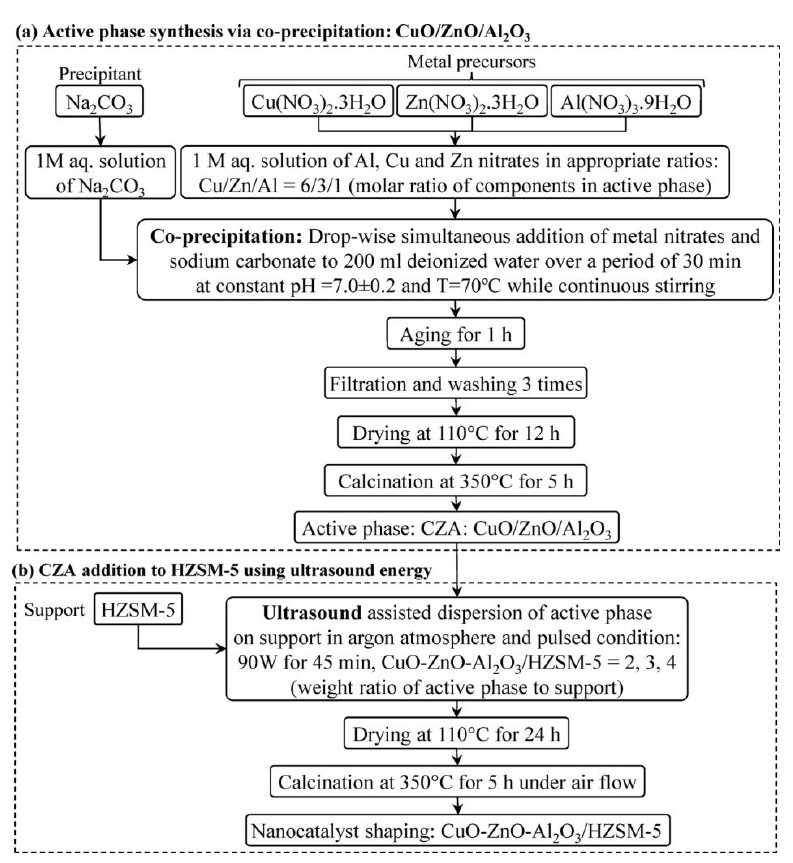
Figure 12. Schematic flow chart for preparation steps of CZA/HZSM-5 catalysts synthesized via combined co-precipitation-ultrasound method with different active phase to support ratios. Reprinted from Ref. [90]. Copyright 2014 with permission of The Royal Society of Chemistry.